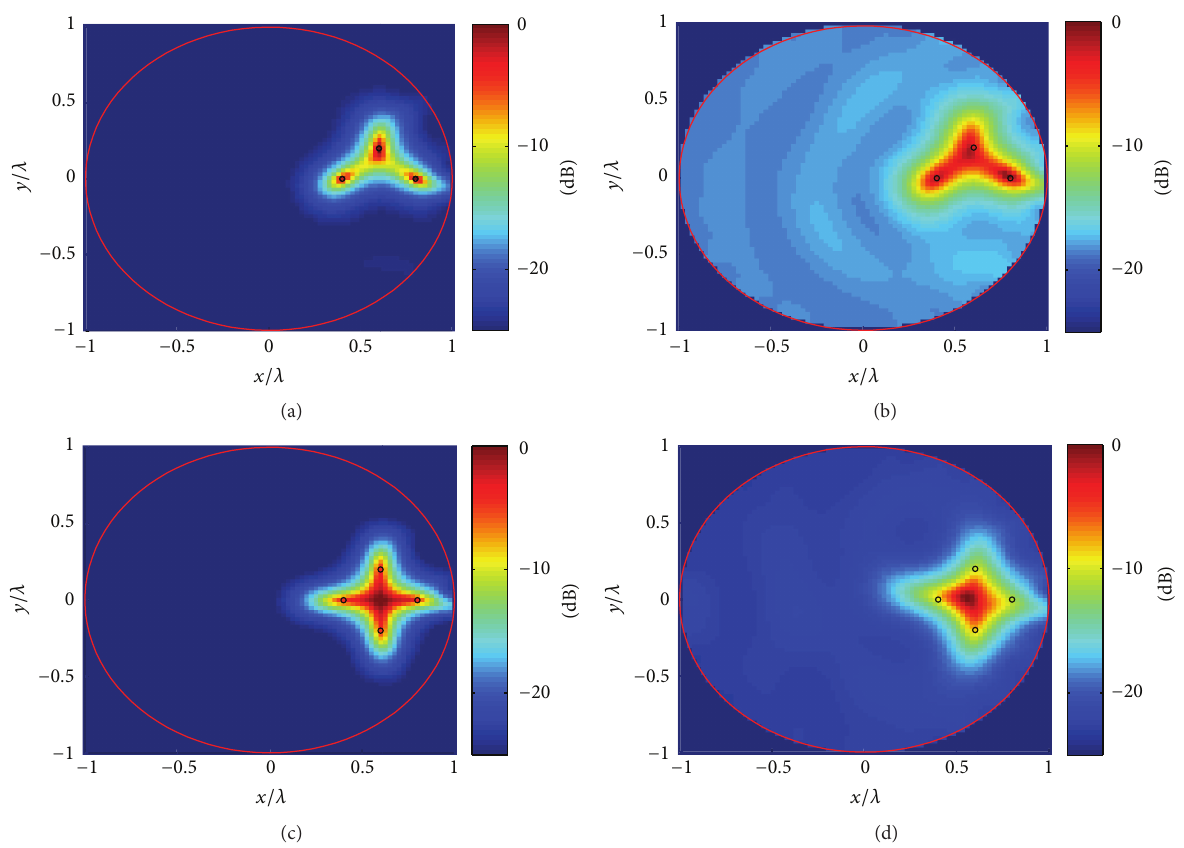
Figure 11: Normalised TRM reconstructions for three scatterers ((a) and (b)) and four scatterers ((c) and (d)). NL noisy data have been exploited with SNR = 20 dB for (a) and (c) and SNR = 10 dB for (b) and (d). Actual scatterers’ positions are denoted by the black